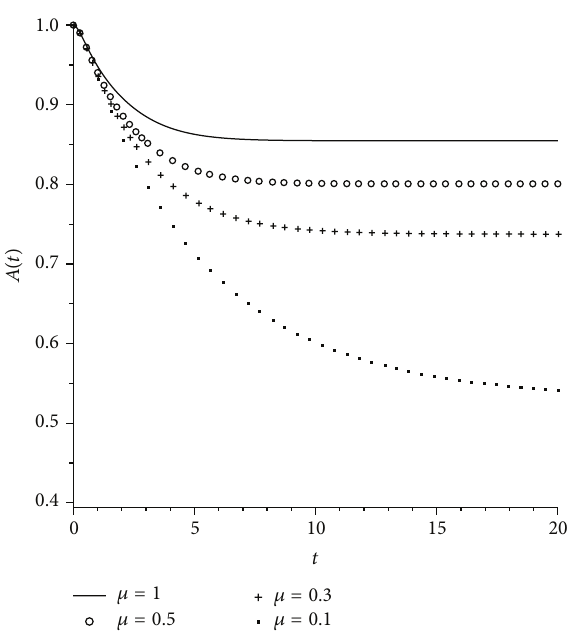
Figure 2: Instantaneous availabilities of the system without warning device with different 𝜇 .